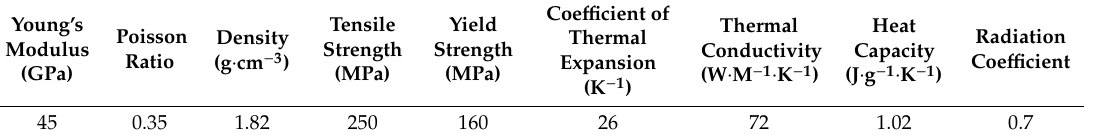
Table 1. Basic parameters of the AZ91D magnesium alloy at room temperature.